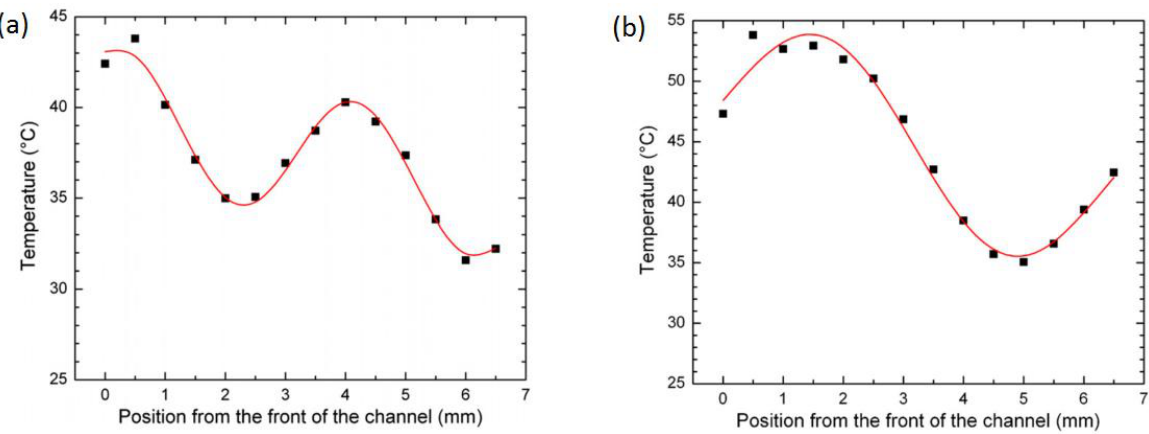
Figure 29. Measured temperature versus distance along the microchannel of an aqueous solution for two microwave excitation frequencies: ( a ) 19 GHz and ( b ) 12GHz. The solid red line is a theoretical temperature fit to the data points in squares. Reprinted with permission from [55]. Copyright 2010, Institute of